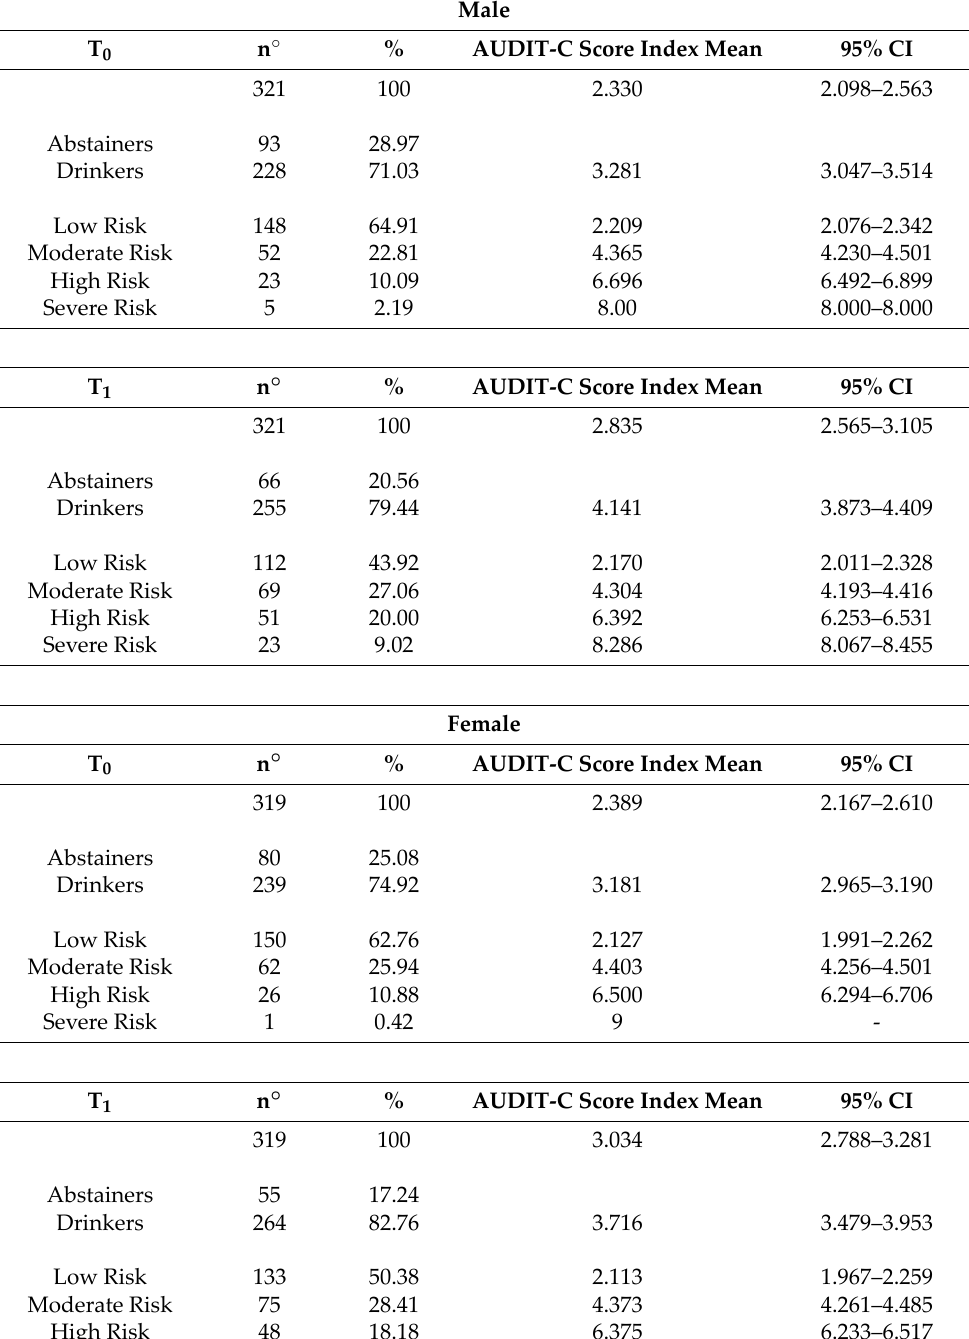
Table 2. Data on the use of alcoholic beverages and the risk of alcohol‑related problems differenti‑ ated between males and females. T 0 , T 1 = times during which the tests were administered and com‑ ◦ pleted; n = number; % = percentage; AUDIT‑C = Alcohol Use Disorders Identification Test‑Concise; CI = Confidence